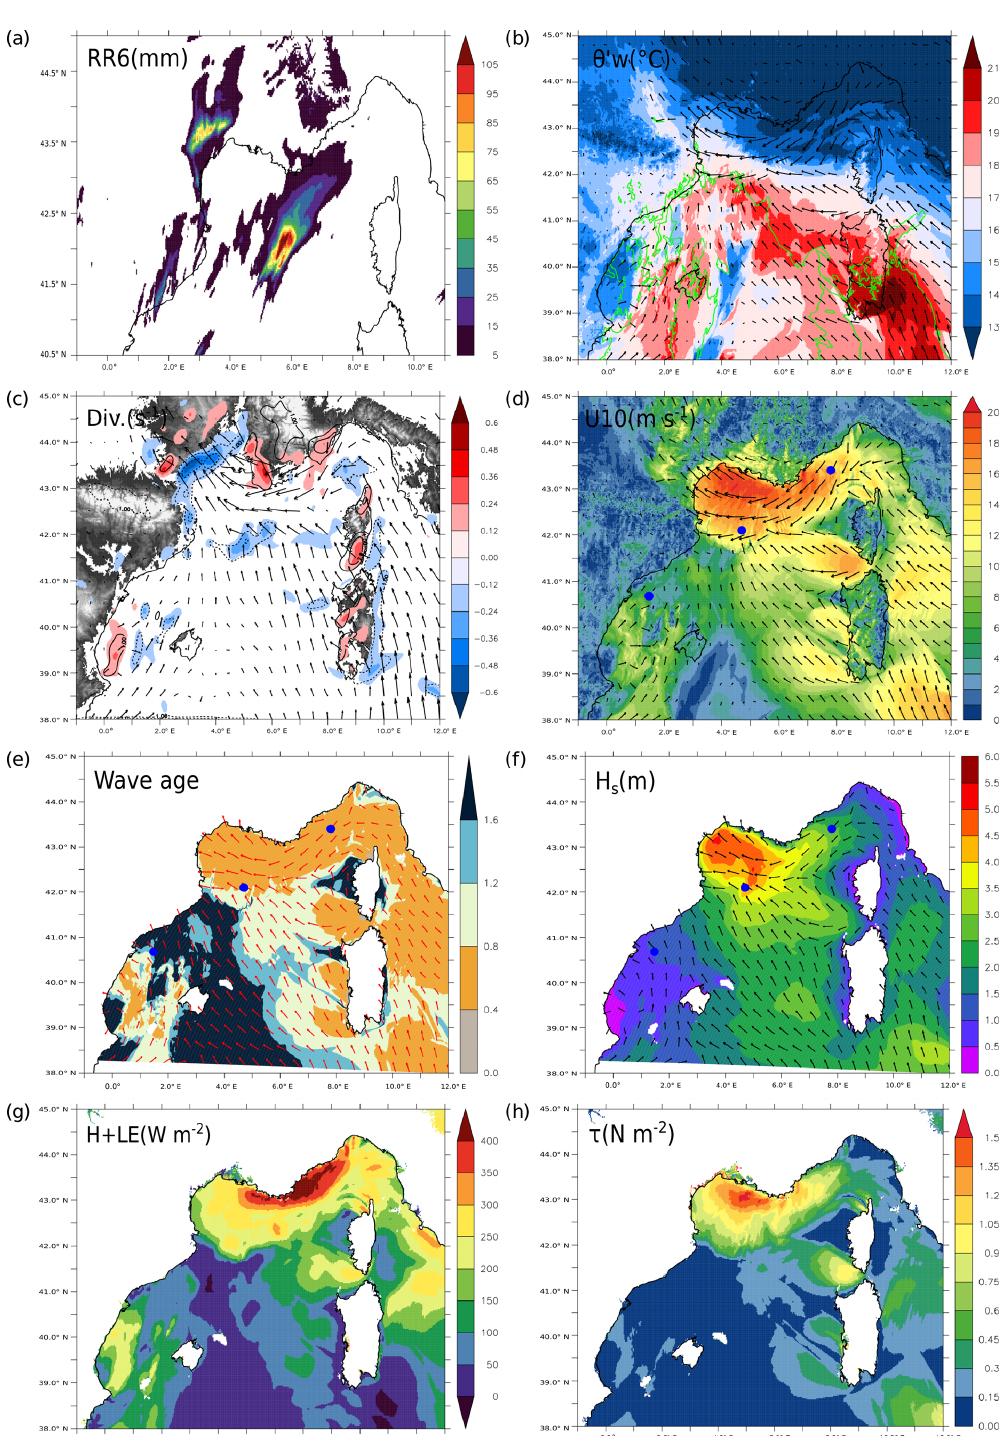
Figure 5. (a) The 6h rainfall amount (mm). (b) The pseudo-adiabatic potential temperature θ w ’ (coloured shading, ◦ C) and wind (ms − 1 , arrows) at 925hPa with the CAPE over 750Jkg − 1 shown using green contours. (c) The wind divergence (coloured shading, 10 − 3 s − 1 , values between -0.12 and 0.12 are masked) at 950hPa, where the black contours are the vertical velocity (Pas − 1 ) at 950hPa and the black arrows are the horizontal winds (ms − 1 ). (d) The 10m wind intensity and direction (ms − 1 ). (e) The wave age and wave direction. (f) The wave significant height (m) and wave direction. (g) The total turbulent heat fluxes ( H , LE) (Wm − 2 ). (h) The wind stress (Nm − 2 ) simulated by AWF at 12:00UTC on 13 October. Blue dots in (d) , (e) and (f) represent the Tarragona, Lion and Azur buoys (from west to